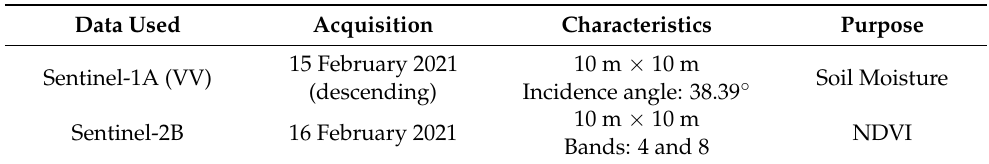
Table 1. Details of the Sentinel–1A and Sentinel–2B images used in this study that are acquired from Copernicus.